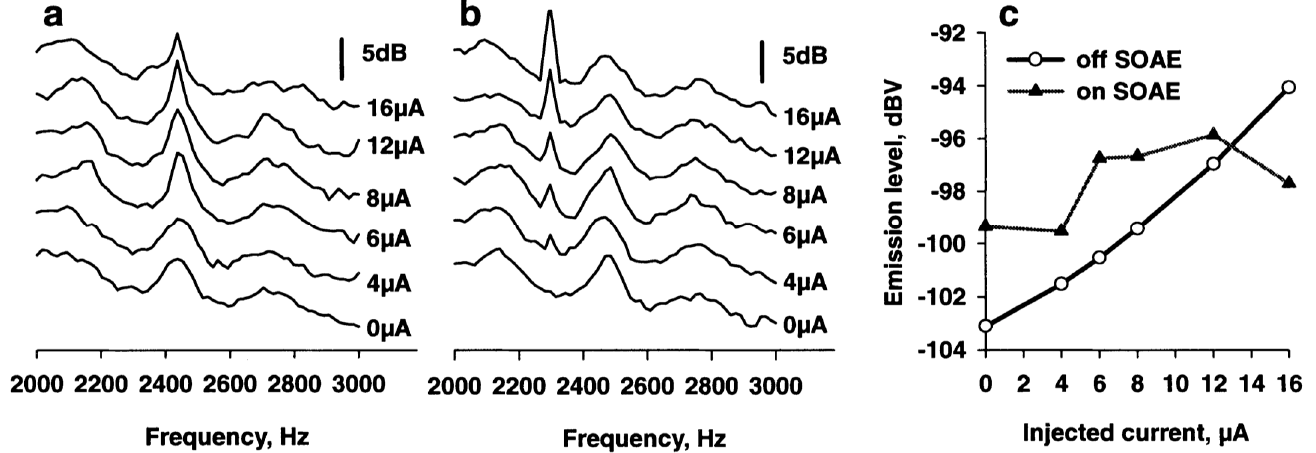
Figure 4. The effects of injected AC current at ( a ) the frequency of an SOAE peak or ( b ) at a frequency with no SOAE peak. The traces in a and b are shifted to avoid overlap. In ( c ) are shown the amplitudes reached in both cases as a function of the injected current. From [54].